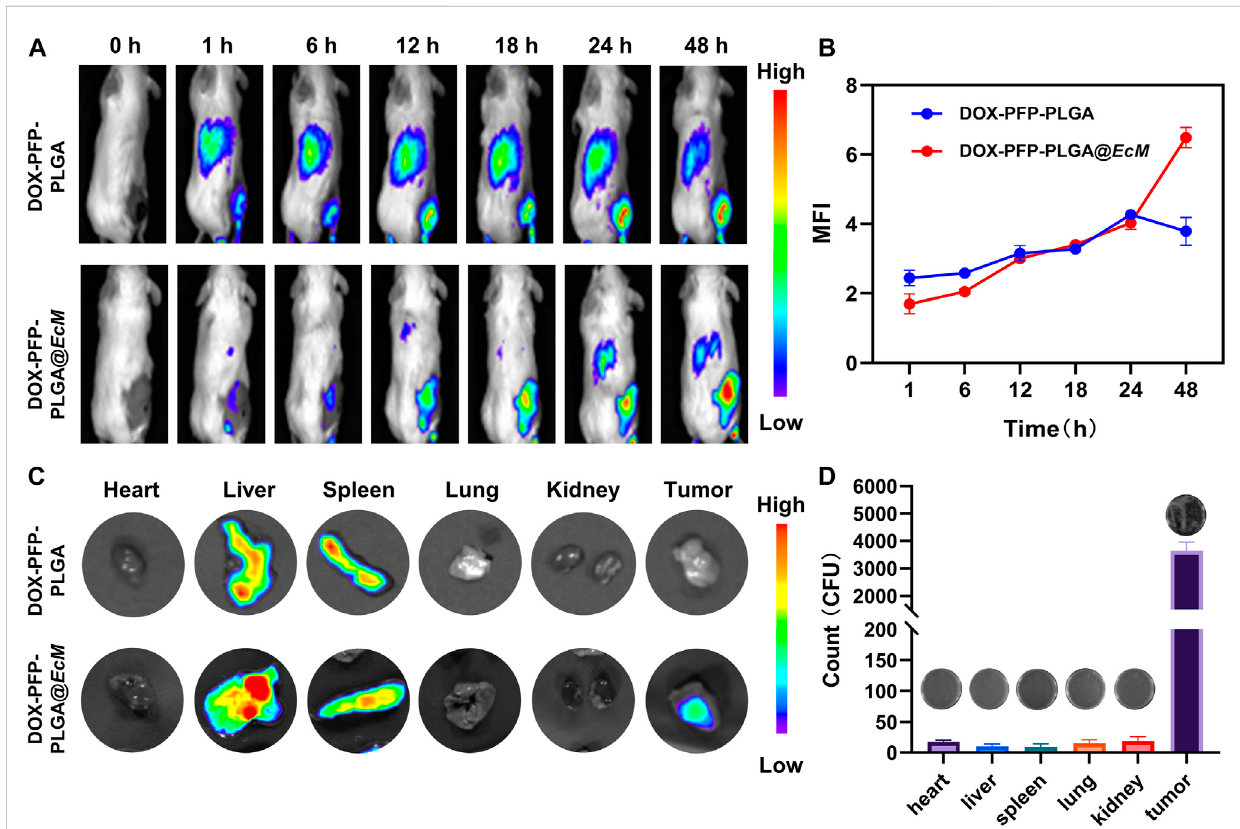
FIGURE 5 In vivo distribution of DOX-PFP-PLGA@ EcM . (A) In vivo fl uorescence imaging of 4T1 tumor-bearing mice at different injection times of DOX-PFP- PLGA and DOX-PFP-PLGA@ EcM and (B) The ratio of the real-time signal intensity and the before injection intensity is used as the measuring FL values in different time points. (C) The bio-distribution of DOX-PFP-PLGA or DOX-PFP-PLGA@EcM in major organs and tissue excised from mice at 48 h post- injection. (D) Homogenates of tumors and organs were cultured on solid agar at 37 °